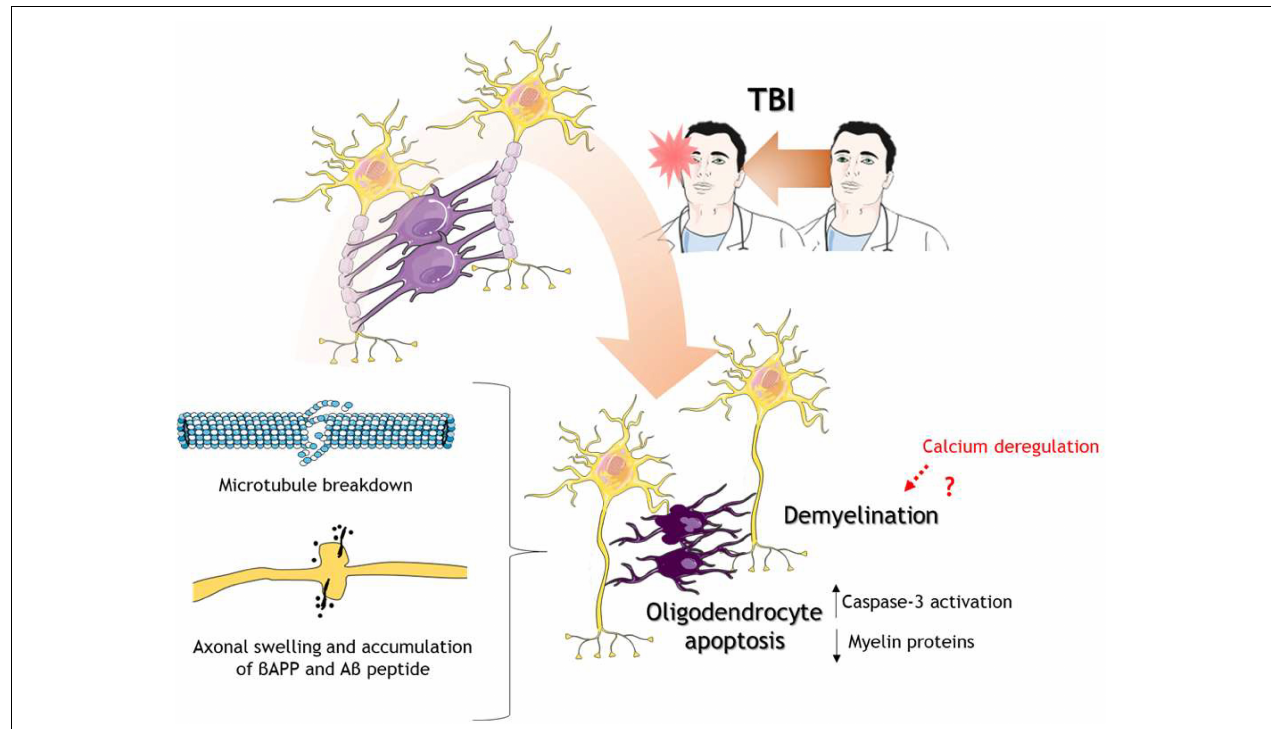
FIGURE 3 | Oligodendrocytes in response to TBI. After TBI of different severities, oligodendrocytes go under the process of programmed cell death or apoptosis. Oligodendrocyte death caused decrease levels of myelin proteins leading to demyelination. There is also microtubule breakdown which translates into axonal transport disruption, axonal swelling, and accumulation of β APP and A β peptides. The cartoon was made using SERVIER Medical Art templates smart.servier.com.